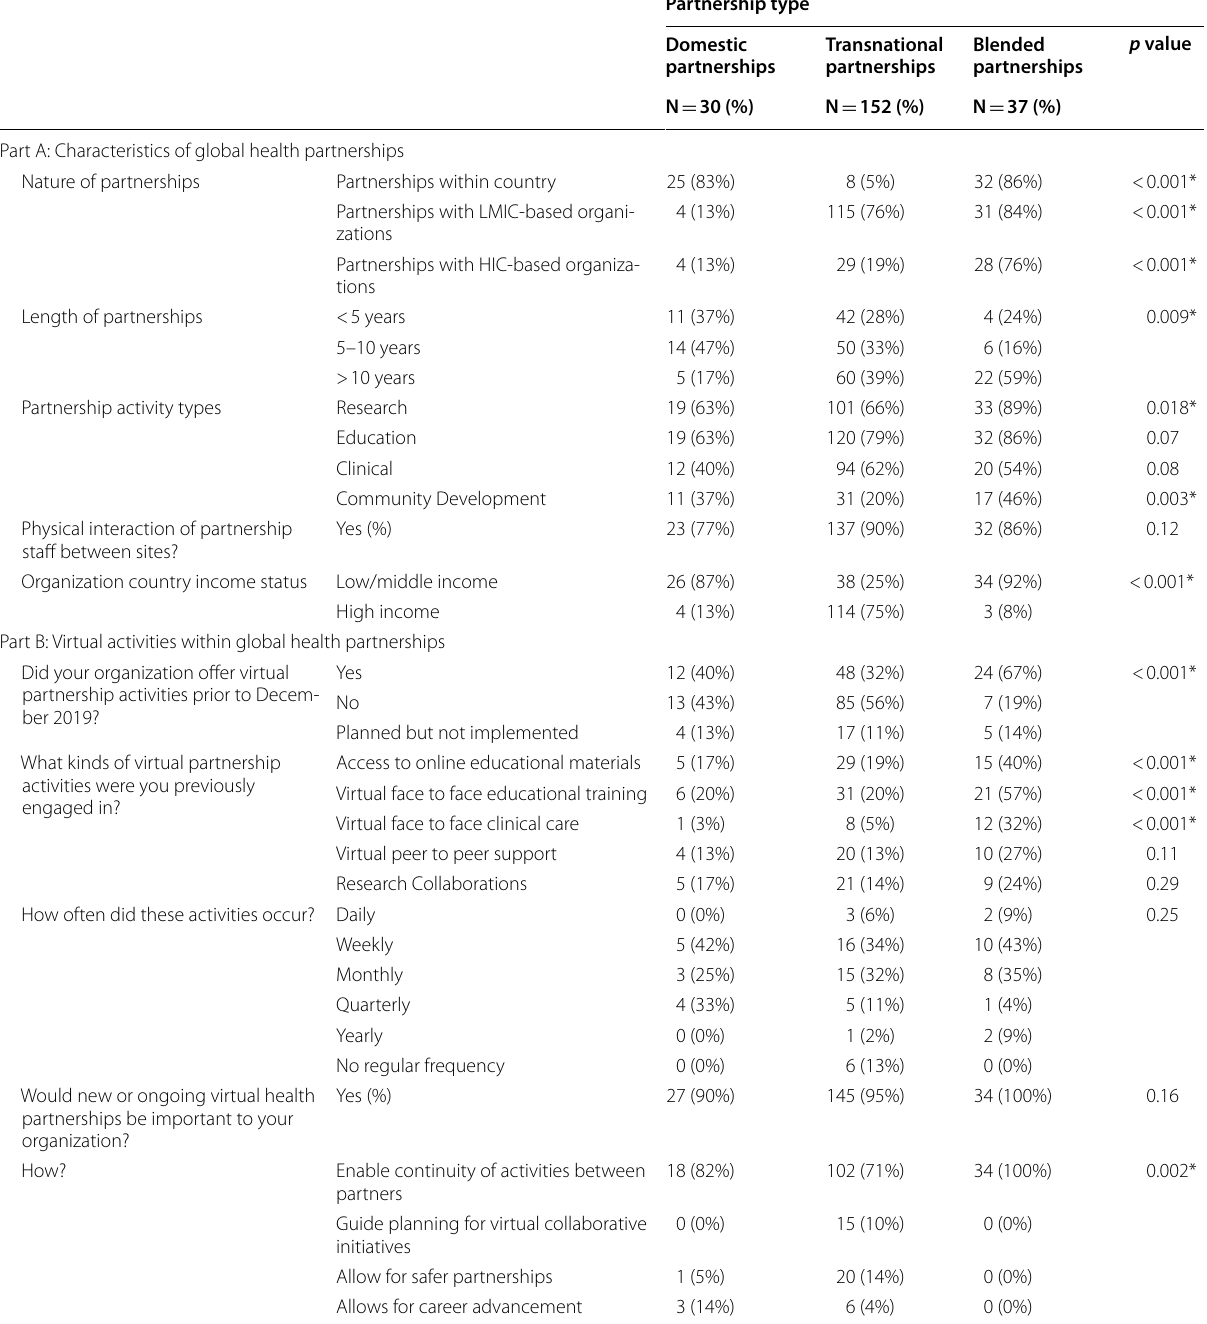
Table 2 Global health partnerships—characterizations and virtual